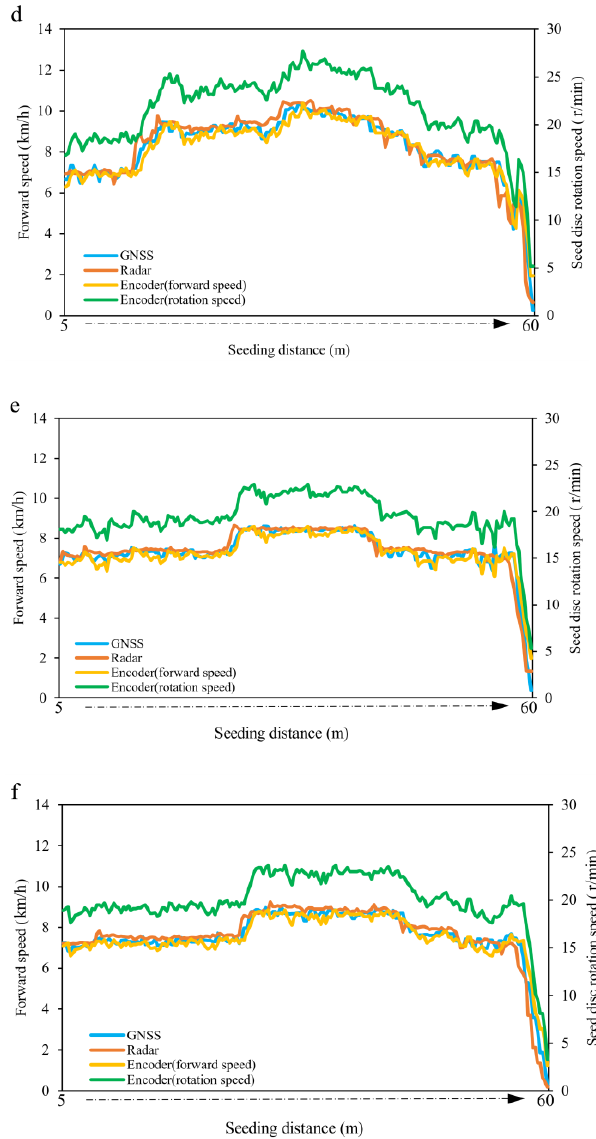
Figure 15. The speed monitoring value of three variable-speed seeding tests (d, e, and f: three variable-speed seeding tests). Table 6. Pearson correlation analysis results of the speed monitoring values of the three speed measurement